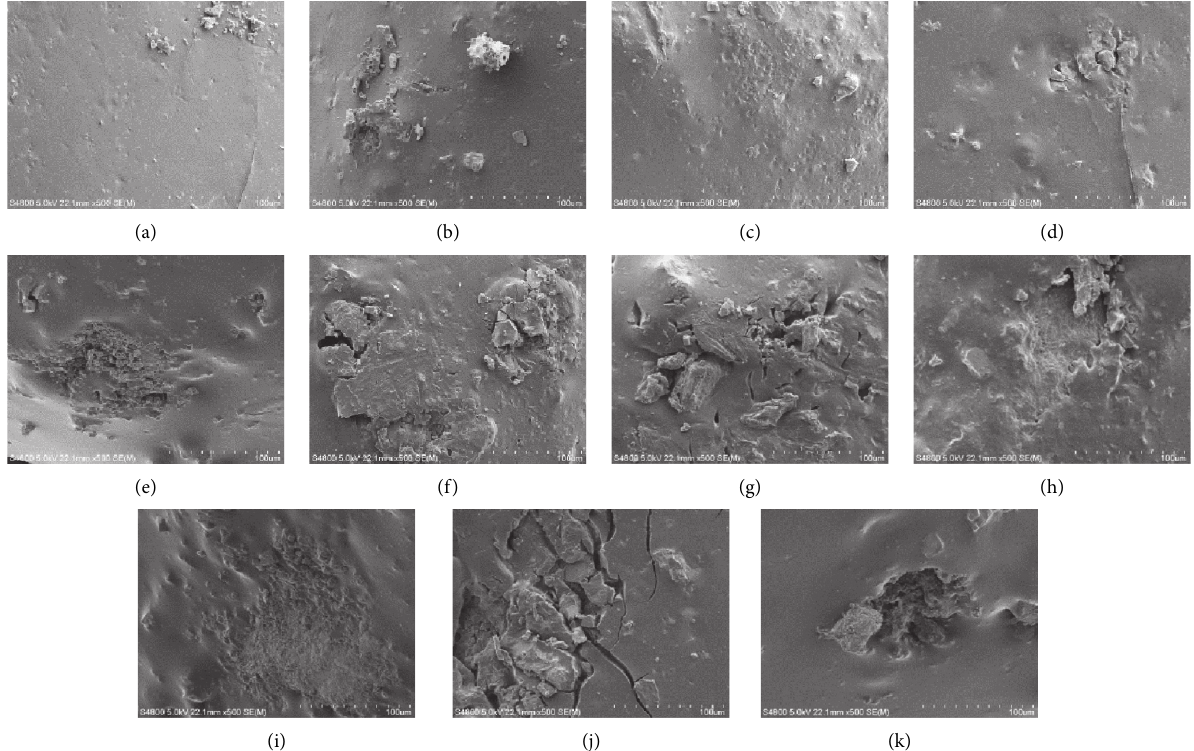
Figure 7: SEM images of PAC with a porosity of 21% after multiple freeze-thaw cycles. (a) No freezing-thawing. (b) 2 cycles. (c) 4 cycles. (d) 6 cycles. (e) 8 cycles. (f) 10 cycles. (g) 12 cycles. (h) 14 cycles. (i) 16 cycles. (j) 18 cycles. (k) 20